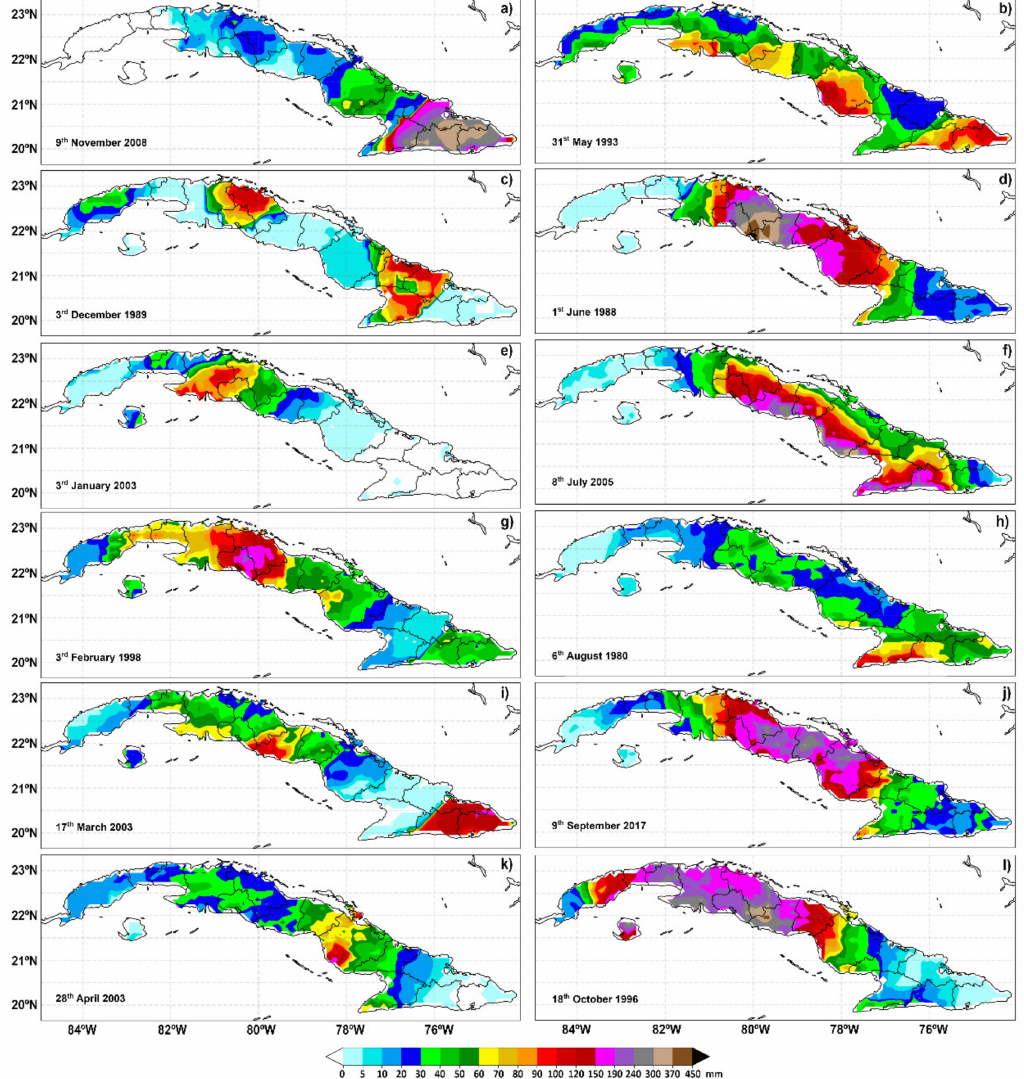
Figure 9. Precipitation pattern for the top monthly extreme precipitation events in the period from 1980 to 2019. In the left panel are shown the months of the dry period (November–April) ( a , c , e , g , i , k ) and in the right panel the rainy period (May–October) ( b , d , f , h , j , k , l